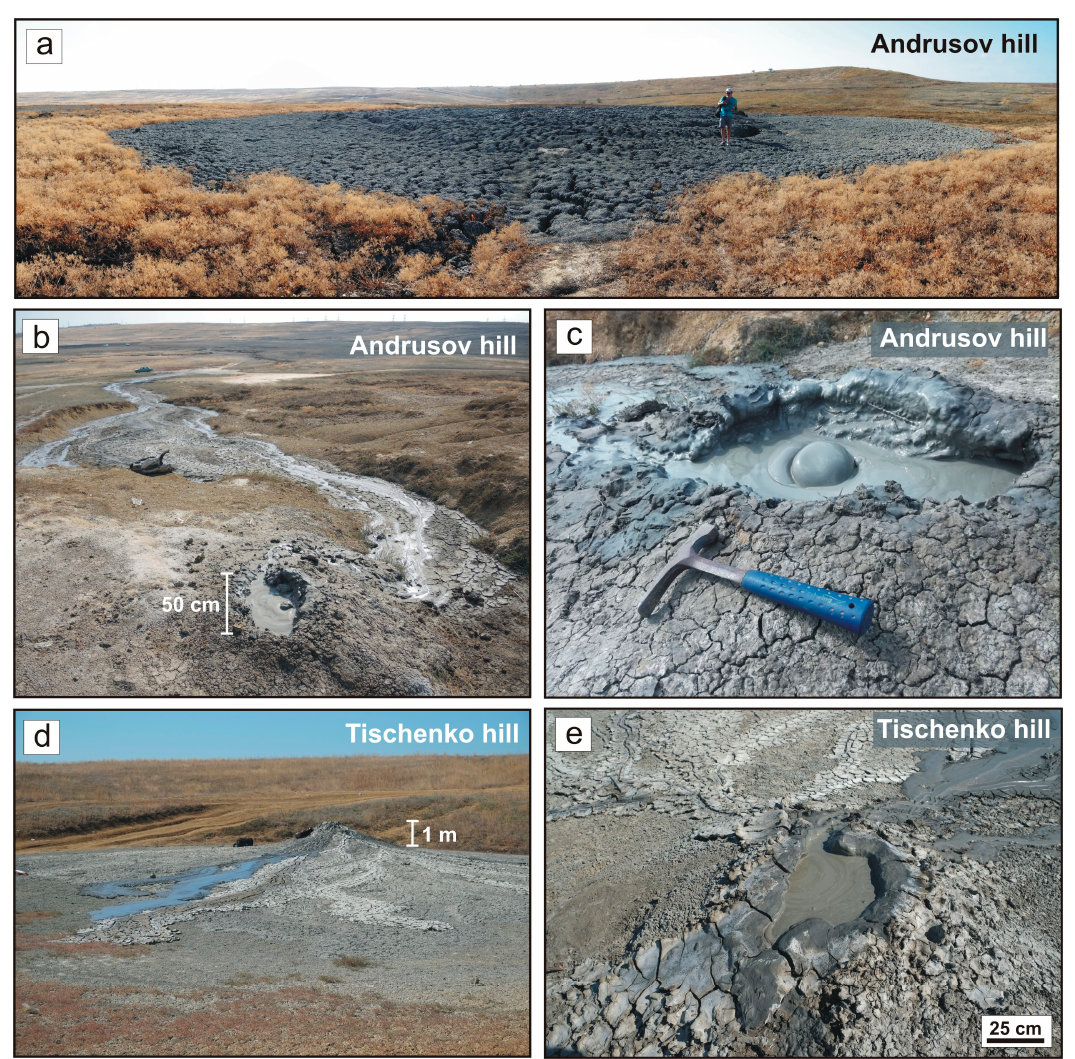
Figure 3. Field view of the Bulganak MV field (September 2017). ( a ) Main eruptive center of Andrusov Hill extruding plastic mud masses. ( b , c ) A bubbling satellite gryphon on the flank of the main cone (Andrusov Hill). ( d ) Panoramic view of Tischenko Hill expulsing liquid mud. ( e ) Bubbling craters at the top of Tischenko Hill.